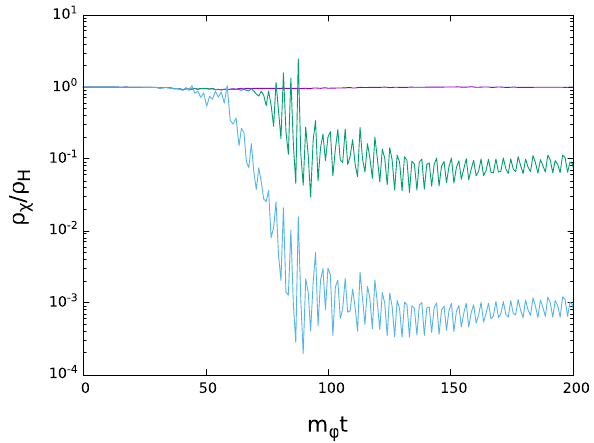
Fig. 6 Energy fraction of χ with respect to that of the SM (basically theHiggs)versus m φ t plot.Choosingthefollowingsetofvalues:( m φ = 10 − 6 M Pl , λ φ = 10 − 14 , λ φχ = 10 − 7 , λ φ H = 10 − 7 , λ H = 10 − 7 , σ φχ = 10 − 10 M σ φ = 10 − 10 M Pl , H Pl ). The plots from the top to bottom correspond to λ χ = 10 − 7 , 10 − 5 and 10 − 3 respectively